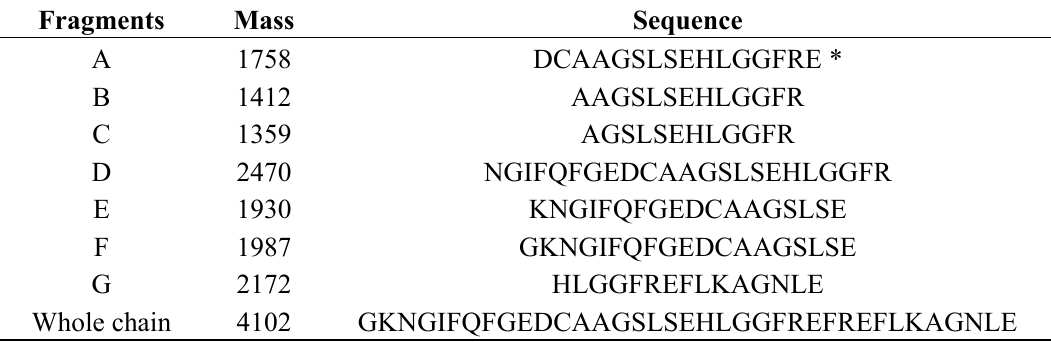
Table 3. De novo peptide sequences detected by ESI-MS/MS of trypsin digestion products of Cs-GP1.